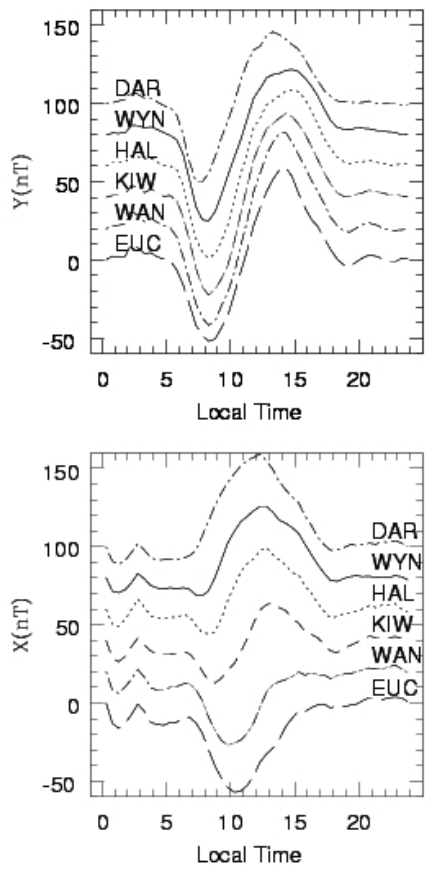
Fig. 4. Magnetic variations for 27 January 1990, plotted every half hour, as for Fig. 2.